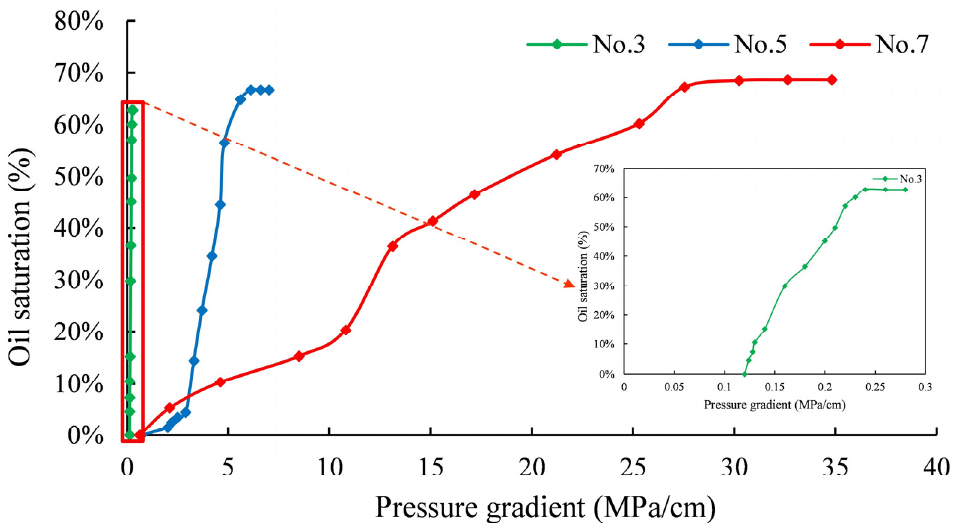
Figure 7. Plots of oil saturation vs. pressure gradient reflecting the oil accumulation process in sandstone reservoirs.